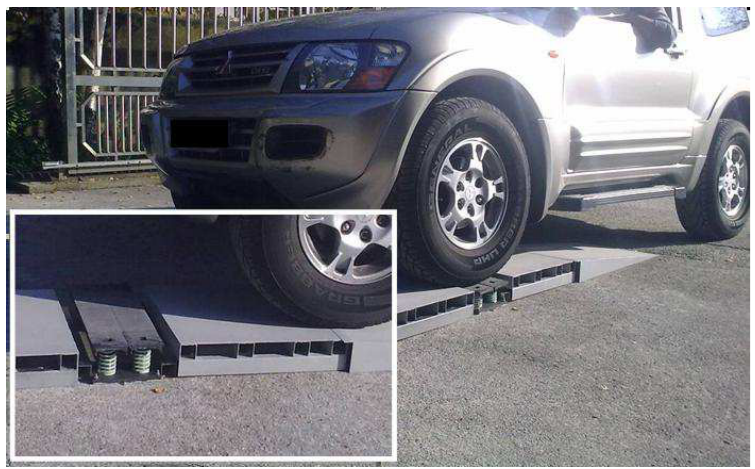
Figure 13. Experimental test on a power